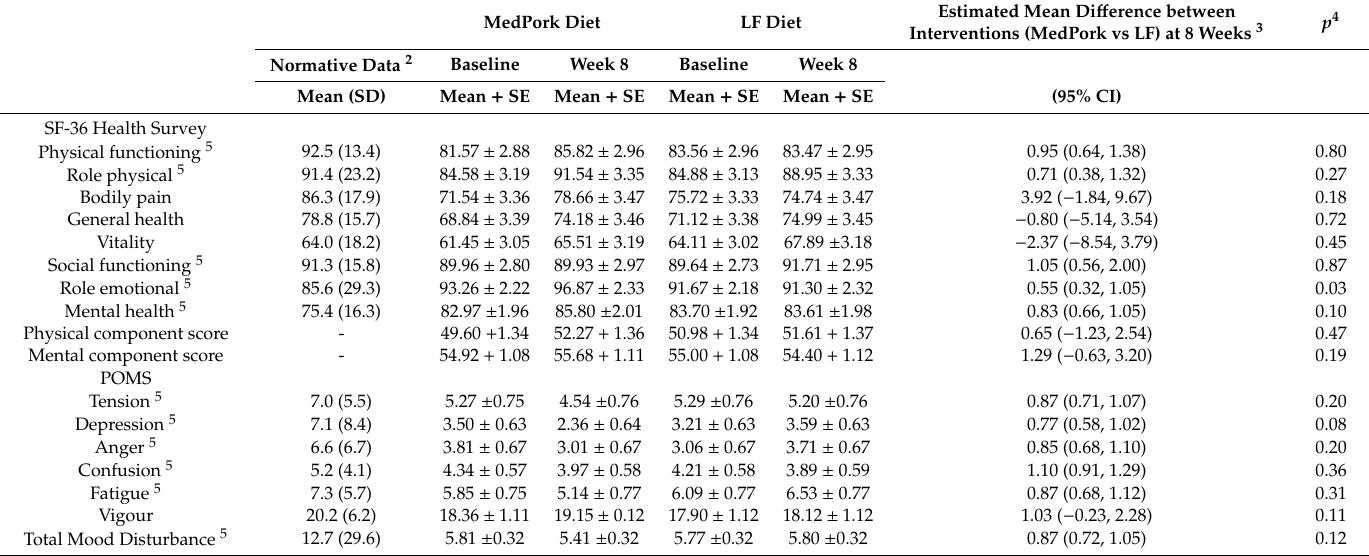
Table 4. SF-36 Health Survey and Profile of Mood States at baseline and week 8, including between group di ff erences ( n = 33) 1